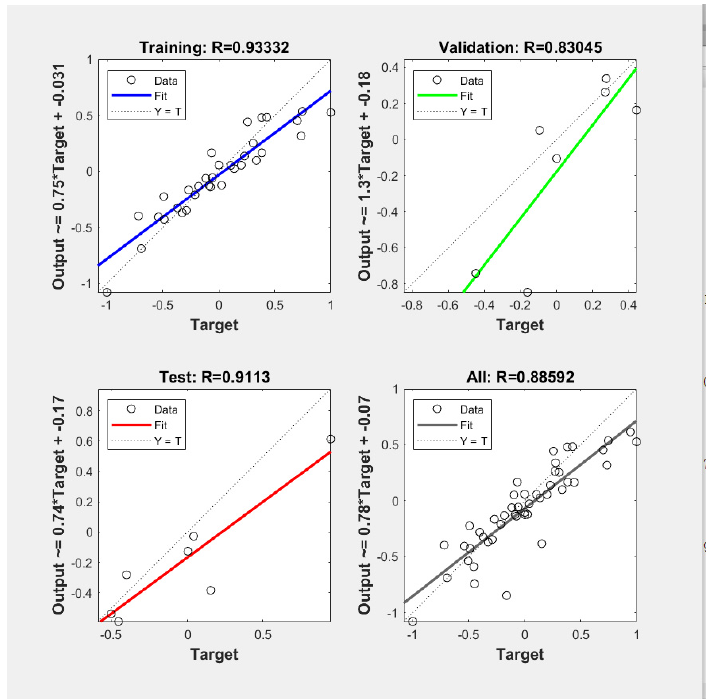
Figure 10. Experimental values versus artificial neural network (ANN) predicted values.